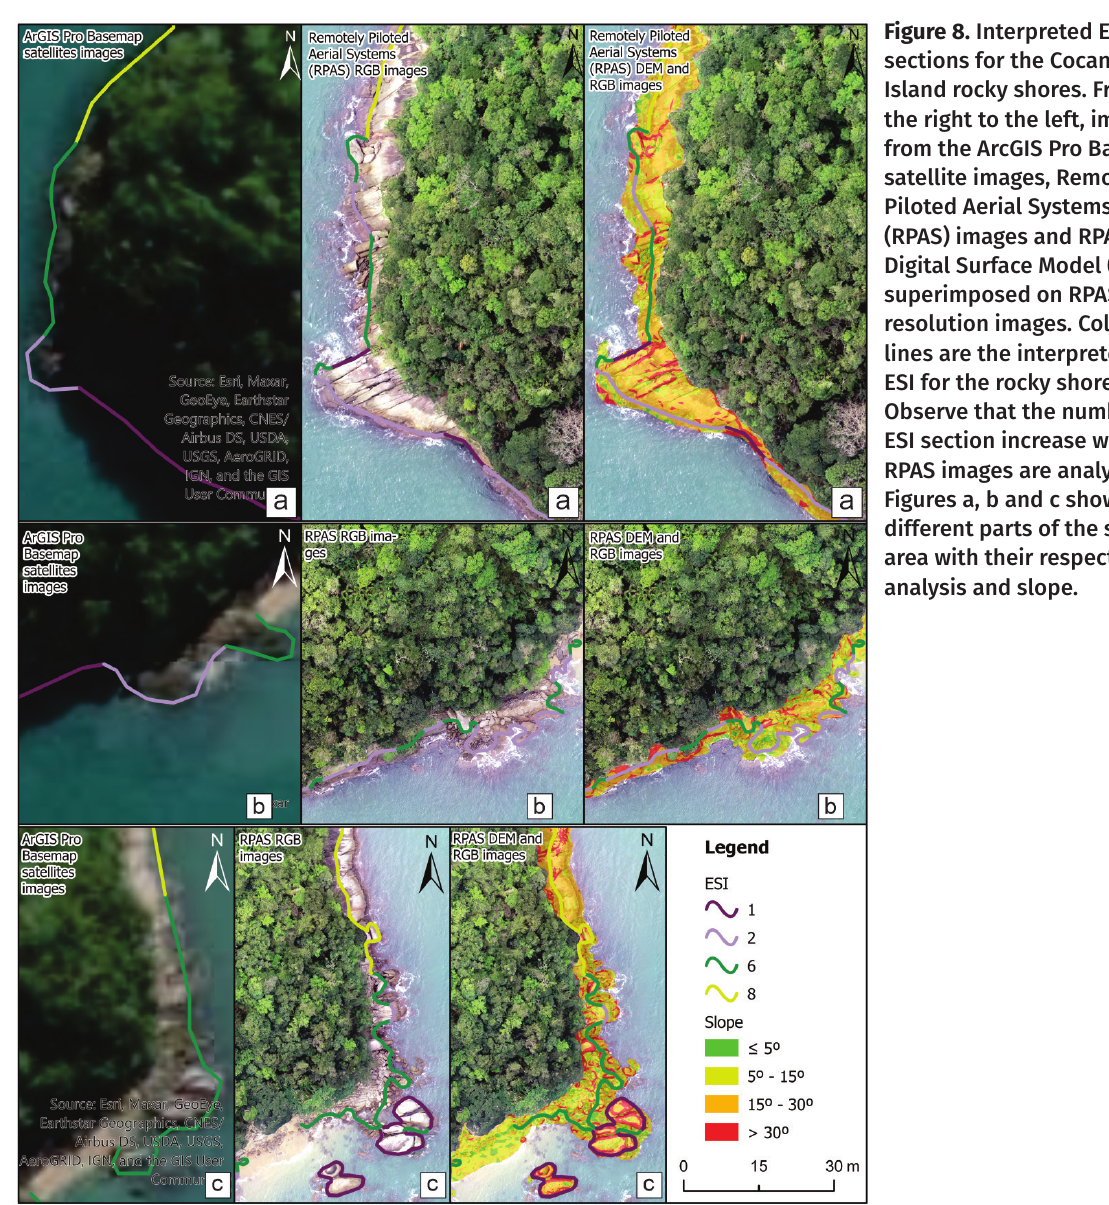
Figure 8. Interpreted ESI sections for the Cocanha Island rocky shores. From the right to the left, images from the ArcGIS Pro Basemap satellite images, Remotely Piloted Aerial Systems (RPAS) images and RPAS Digital Surface Model (DSM) superimposed on RPAS high- resolution images. Colored lines are the interpreted ESI for the rocky shores. Observe that the number of ESI section increase when RPAS images are analyzed. Figures a, b and c shows different parts of the studied area with their respective ESI analysis and